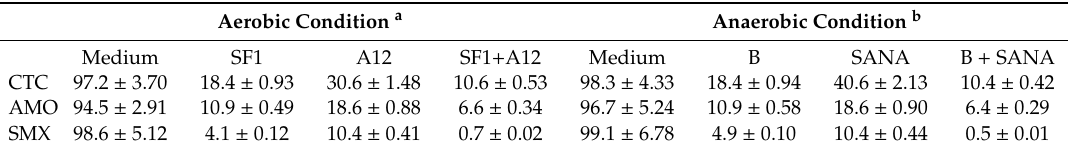
Remaining percentages (%) of chlortetracycline (CTC), amoxicillin (AMO) and sulfamethoxazole (SMX) after incubation with antibiotic-degrading